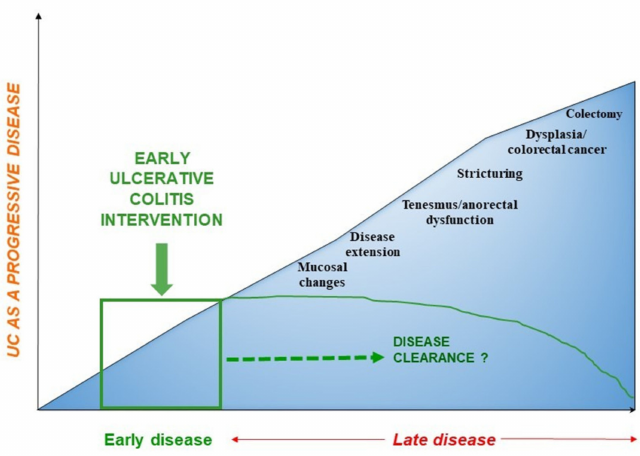
Figure 1. Disease progression in patients with ulcerative colitis: towards “disease